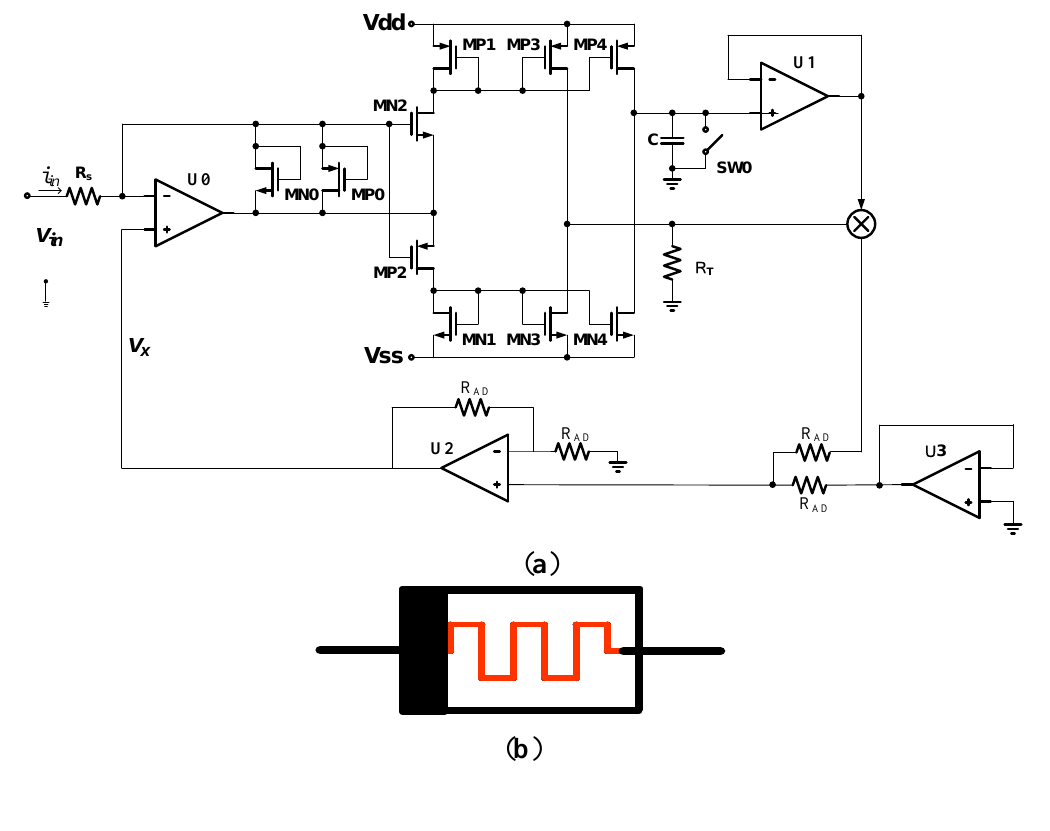
Figure 3. incrementally-biased memristor emulator circuit ( a ) memristor emulator circuit; ( b ) a schematic of memristor